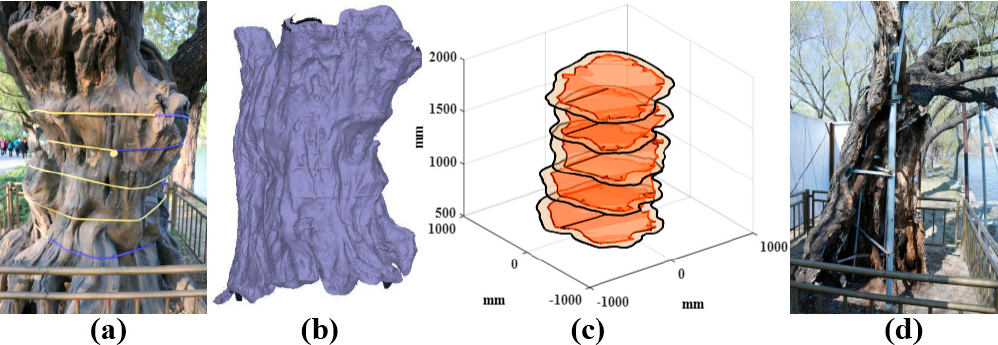
Figure 12. The detection result of tree L05 in the Summer Palace. ( a ) The willow tree in the field; ( b ) The trunk reconfiguration model; ( c ) The 3D analysis result; ( d ) The rejuvenation in order to compare with the detection results.